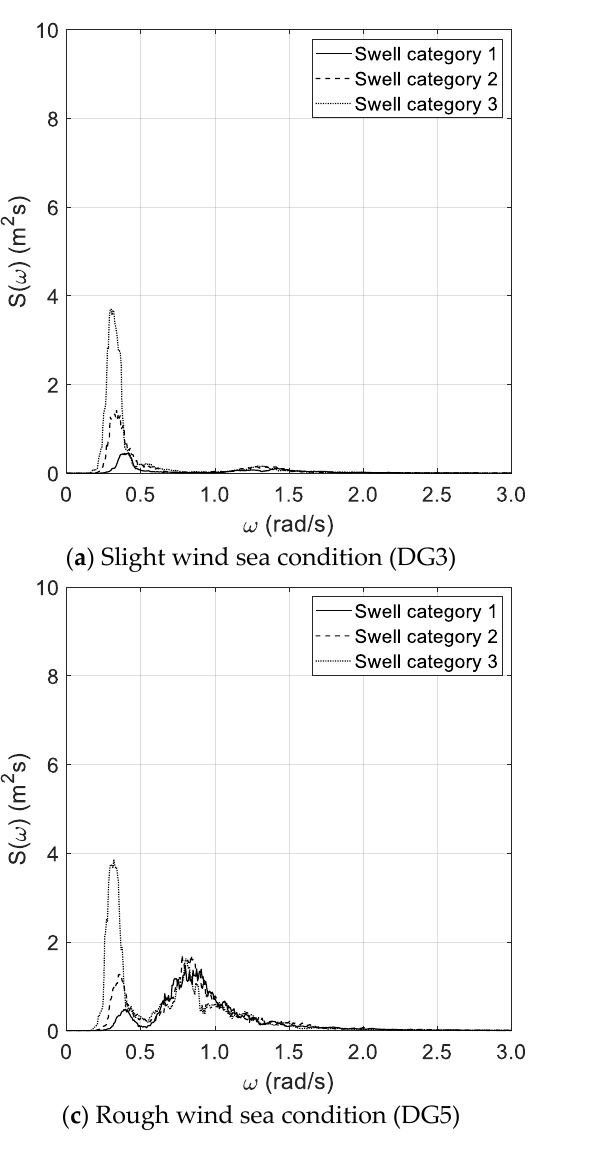
Figure 4. Spectral analysis (Thomson)—short duration with low frequency resolution.